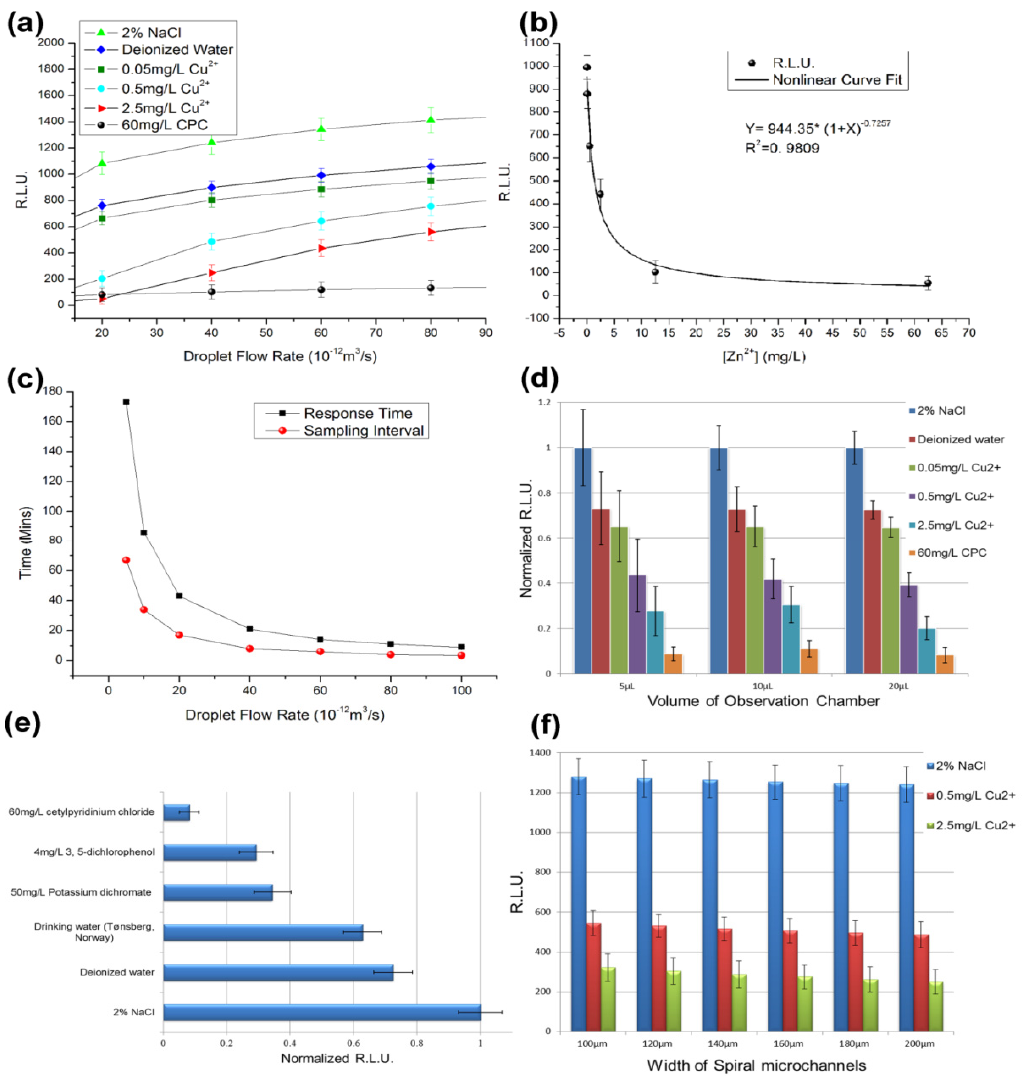
Figure 4. Toxicity test results for the V. fischeri cell-based sensing system. ( a ) The six sample solutions (2% NaCl, deionized water, 0.05 mg/L Cu 2+ solution, 0.5 mg/L Cu 2+